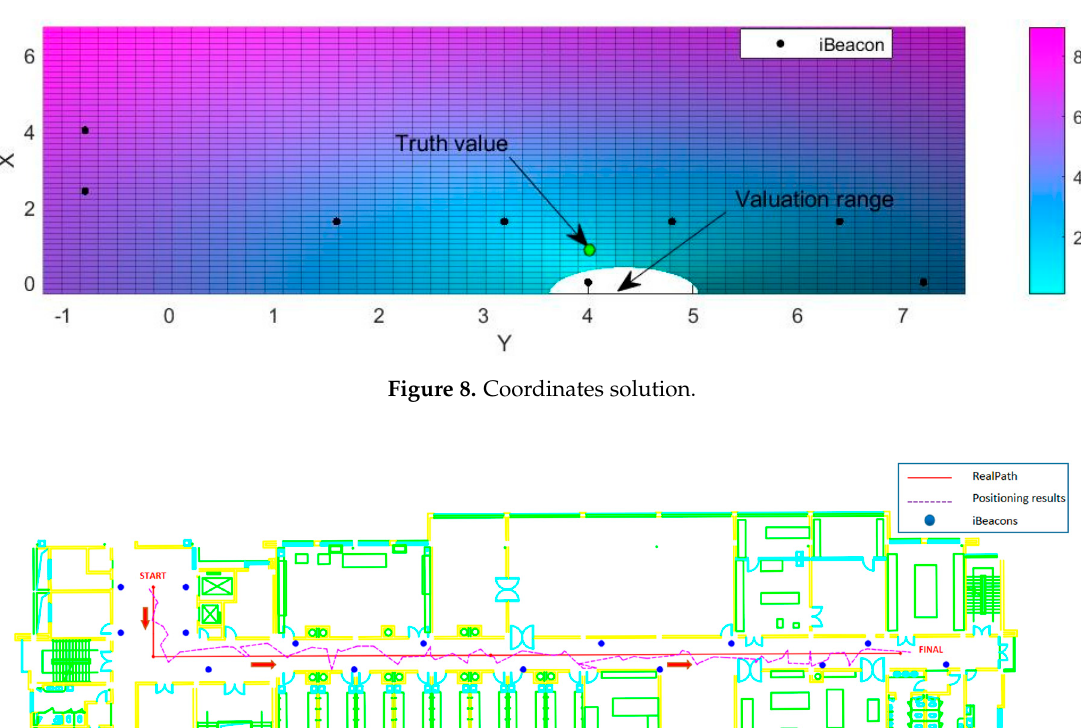
Figure 8. Coordinates solution.